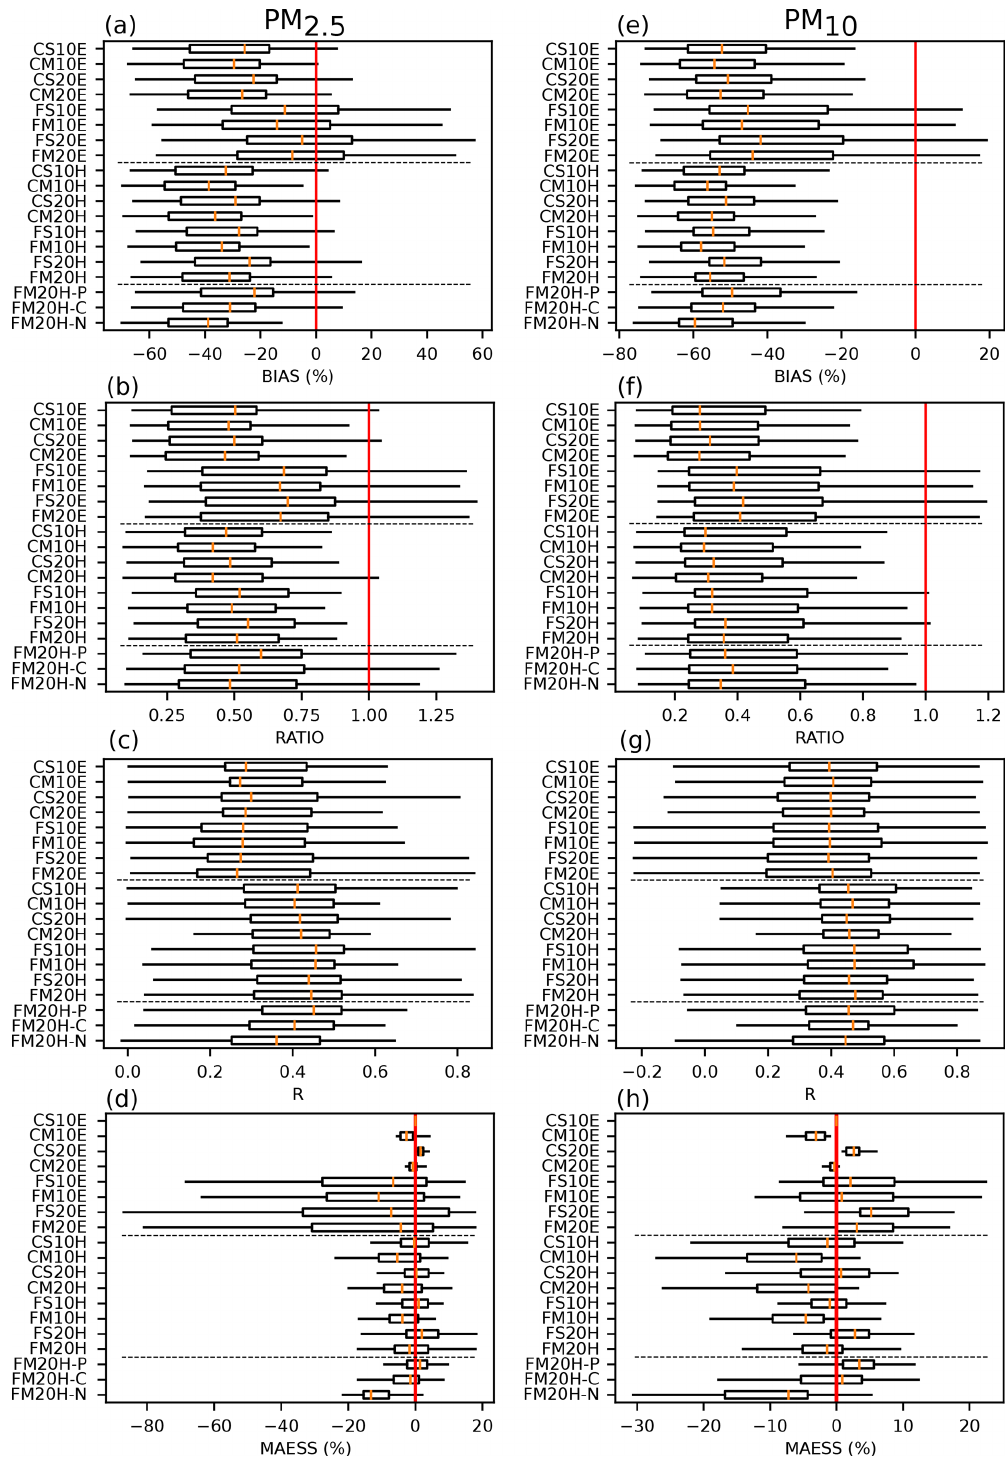
Figure 5. Temporal verification results for daily near-surface maximum PM 2 . 5 (a–d) and PM 10 (e–h) . (a, e) Percentage bias (BIAS), (b, f) Pearson correlation coefficient ( R ), (c, g) ratio of standard deviation (RATIO), (d, h) mean absolute error skill score (MAESS) with reference to the base experiment CS10E. Box plots are calculated upon the pointwise verification results at all available stations. Experiments are explained and grouped as in Table